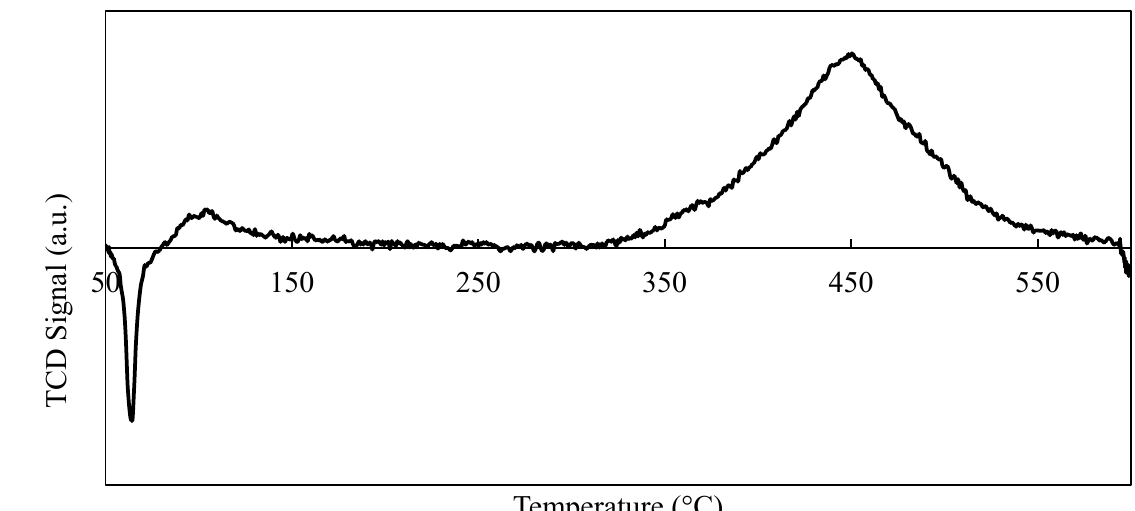
◦ C/min) Pretreatment: 500 ◦ C in 10% O 2 /He, Ramp rate = 10